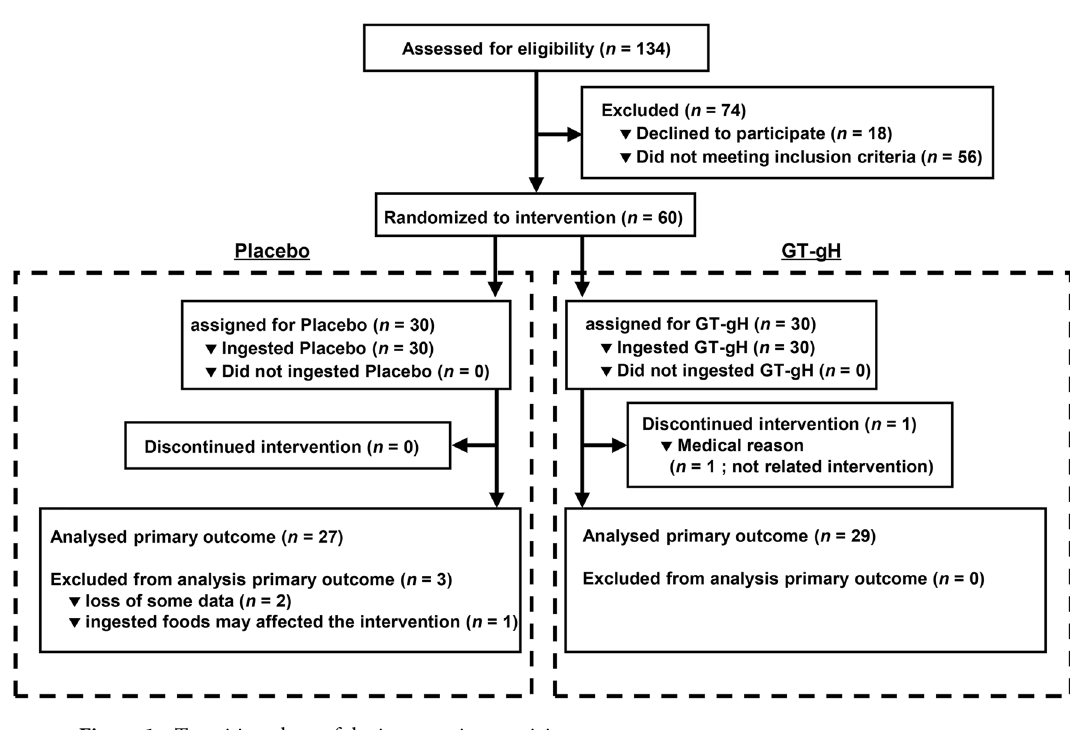
Figure 1. Transition chart of the intervention